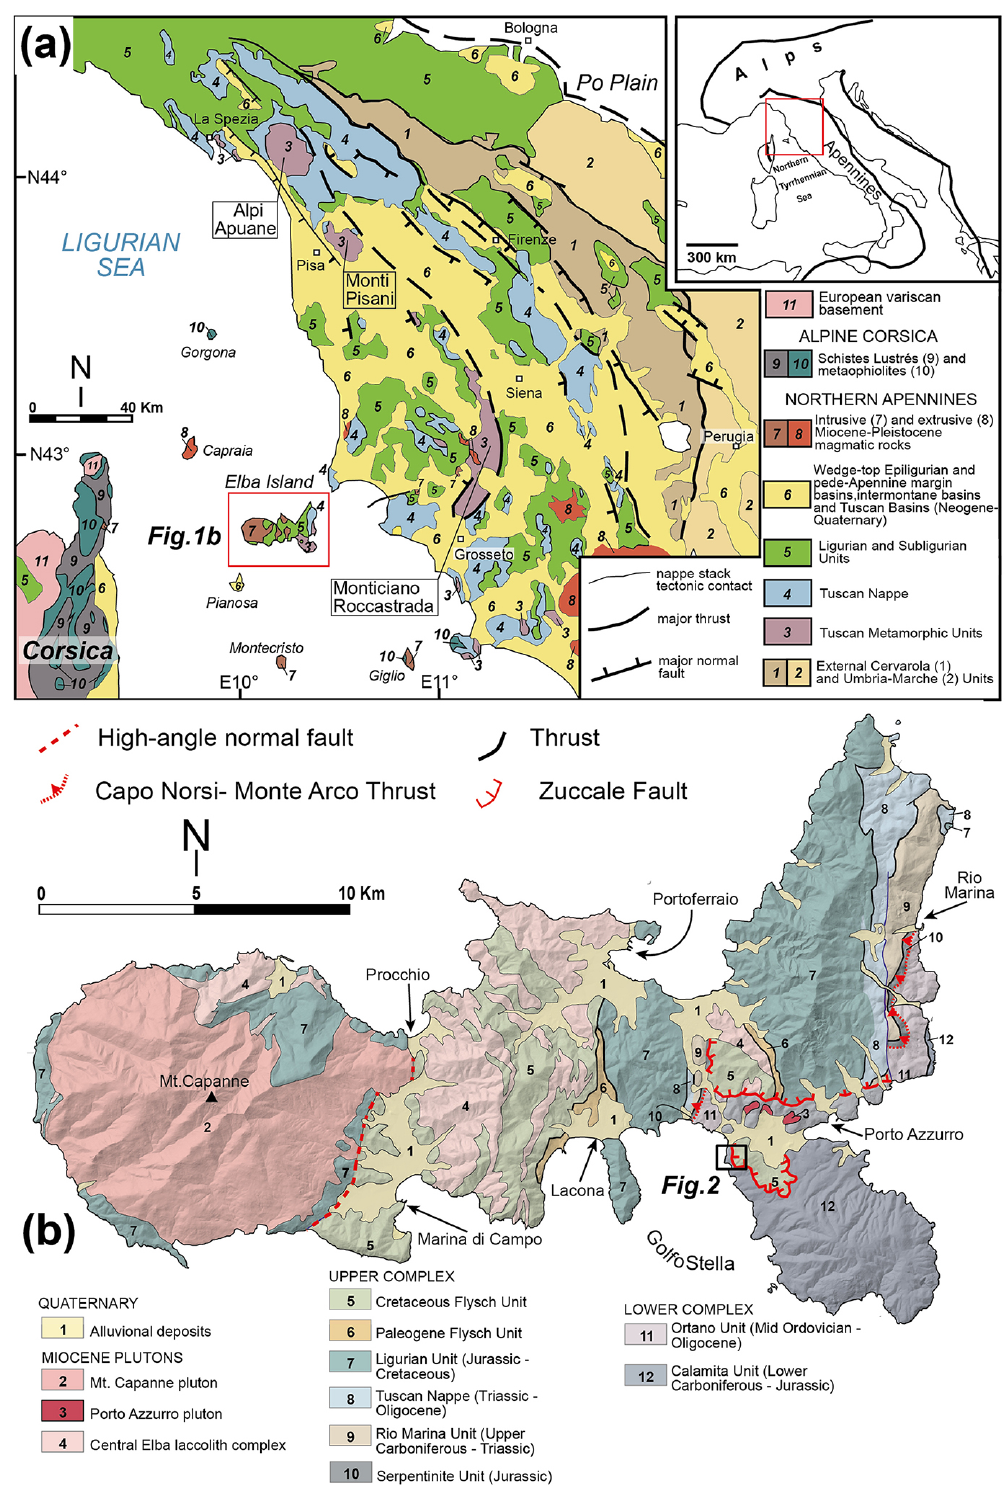
Figure 1. (a) Geological sketch map of the Northern Apennines. Elba is framed by the red box and shown in detail in (b) . (b) Simplified geological map of Elba. The black square indicates the position of Punta Zuccale, the geology of which is shown in Fig. 2. Modified after Viola et al.